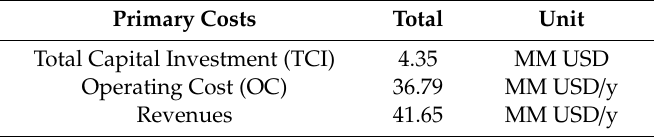
Table 6. The primary costs for the mass integrated approach for a shrimp biorefinery.